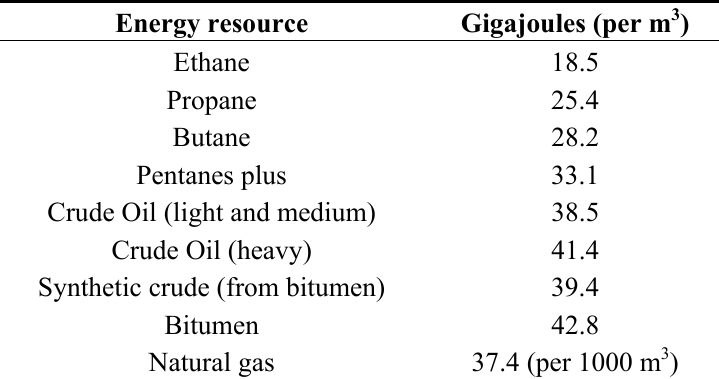
Table 2. Energy conversion factors